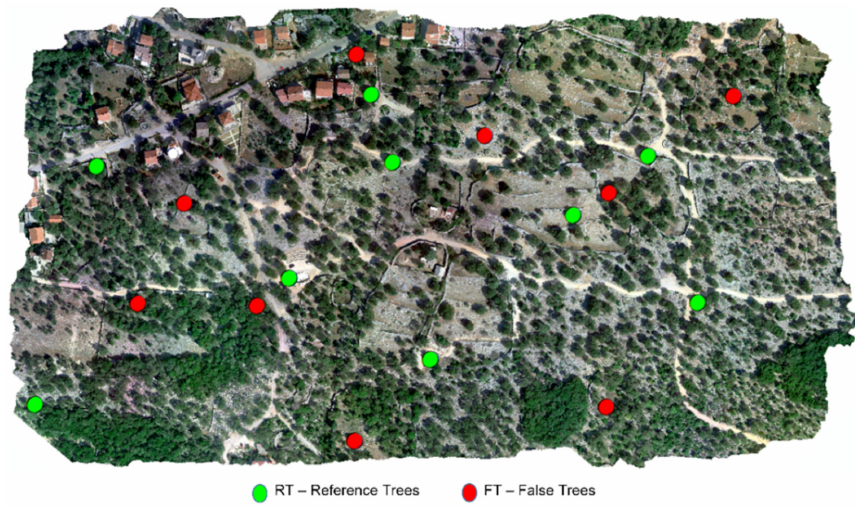
Figure 8. Distribution of RT and FT.